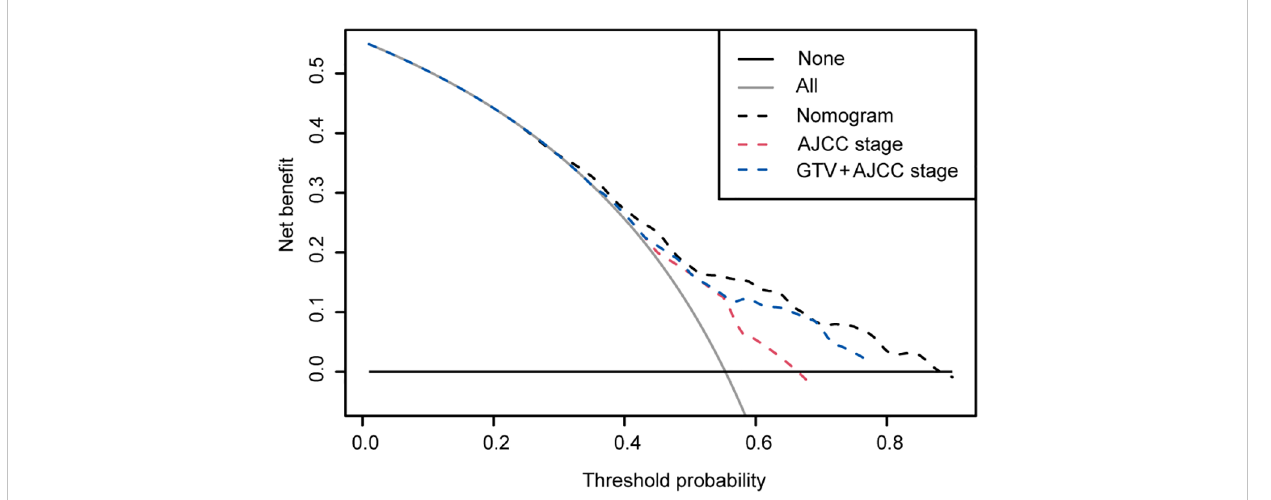
FIGURE 3 Decision curve analysis of the nomogram, the AJCC stage and GTV + AJCC stage in the training cohort. x-axis, threshold probability; y-axis, the standardized net bene fi t; gray line, the hypothesis that all patients survived for 5 years; black line, the hypothesis that all patients did not survive for 5 years. If one model achieves the highest net bene fi t compared with other models or any simple strategies at any given threshold, it is of clinical signi fi